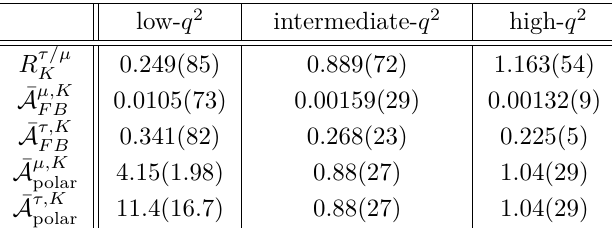
Table 8 . The theoretical values of the ratio of the τ/µ decay rates R τ/µ backward asymmetry ¯ A ‘,π ( K ) and the normalized lepton polarization asymmetry ¯ A ‘,π ( K ) FB in the three selected q 2 -bins in the case of the semileptonic B → π‘ν the combined LQCD data of table 1 as inputs for our DM method.